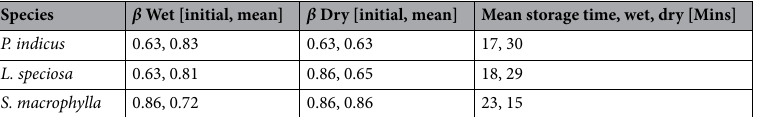
Table 1. Initial and mean values of the species capacitance parameter during wet and dry seasons. The last column indicates the storage time in minutes based on the mean β value.